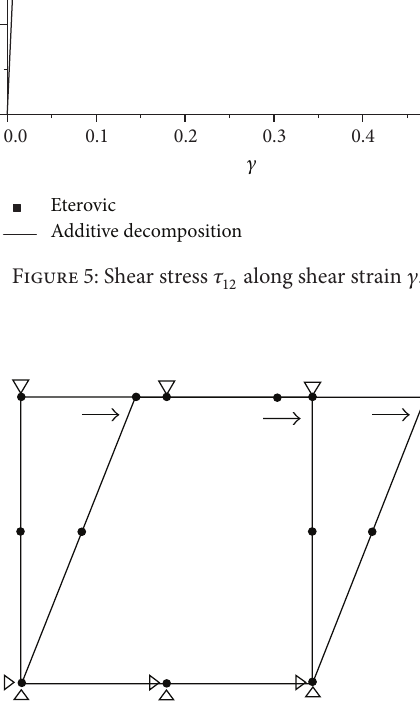
Figure 6: FEM model for shear load analyses of multiplicative and additive decomposition methods.